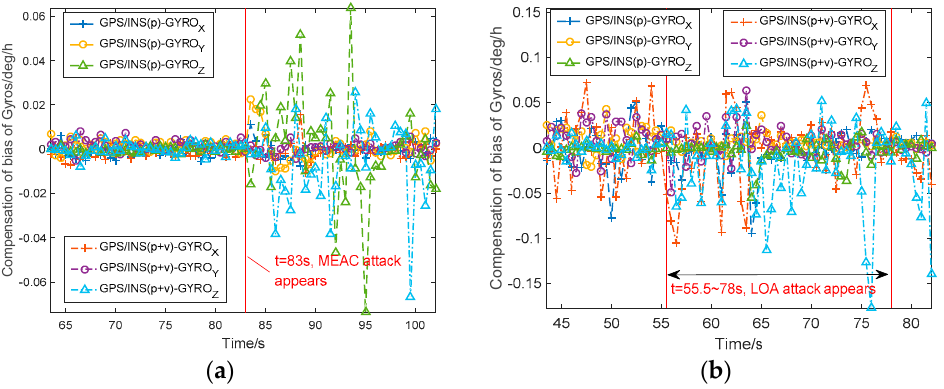
Figure 5. The compensation of gyroscope bias in GPS/INS with position and position/velocity fusions under MEAC attack ( a ) and LOA attack ( b ).